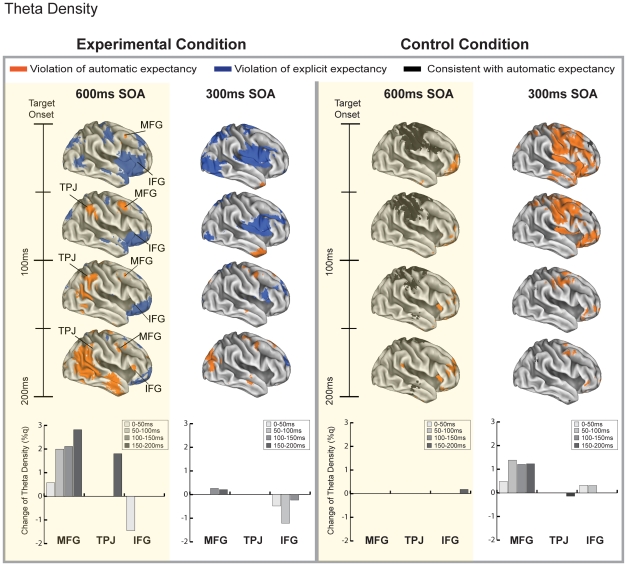
MSBF Results.Significant voxel values (p<.00001) indexing the approximate locations of cortical regions showing modulations of theta density in a direct contrast between congruent target (violations of automatic expectancy, depicted in orange) and incongruent target (violations of explicit expectancy, depicted in blue) occurring before response execution in the experimental and control conditions at 600 and 300 ms SOA. Bar graphs depict the significant theta density change for each ventrolateral region of interest (MFG [x = 45, y = 6, z = 46], TPJ [x = 52, y = −50, z = 28], and IFG [x = 48, y = 14, z = 10]) as a function of time.